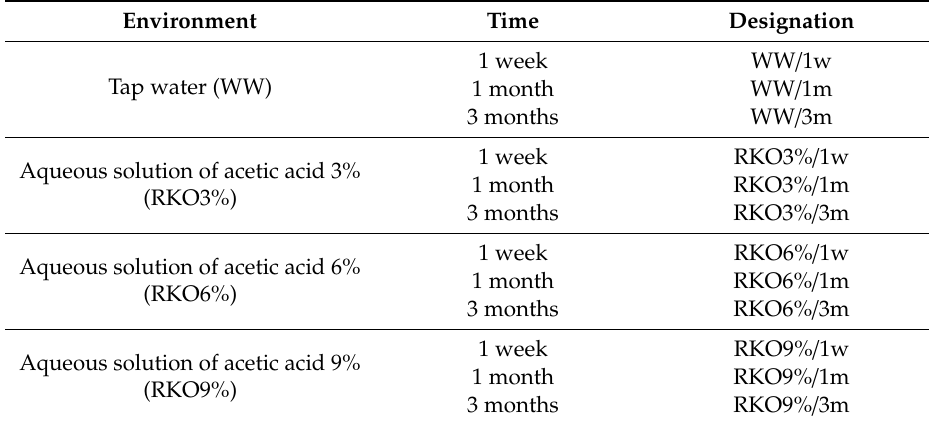
Table 3. Exploitation environments and times of the samples of the epoxy compounds: